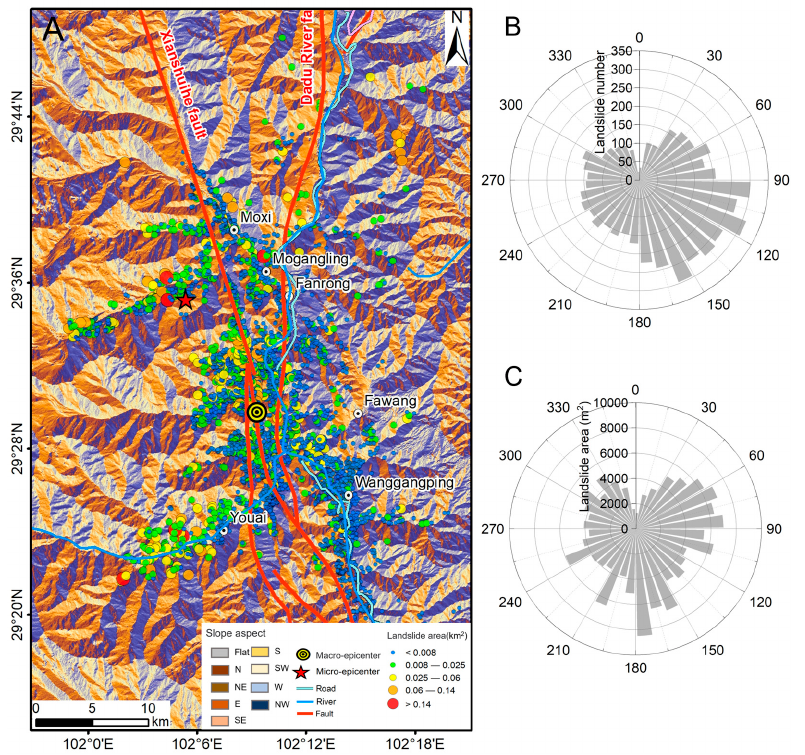
Figure 13. ( A ) coseismic landslide distribution with slope aspect; ( B ) landslide number and aspect; ( C ) landslide area and aspect.